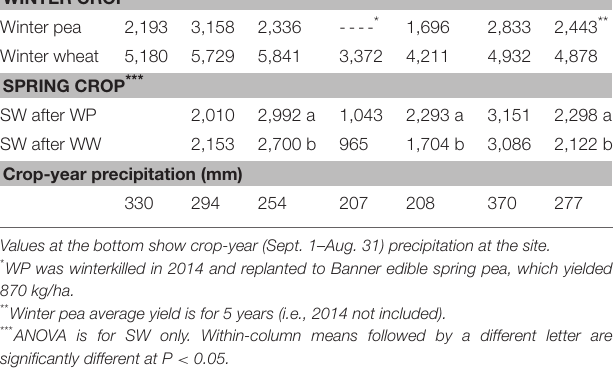
TABLE 4 | Ritzville soft white wheat market prices during the first week of September and winter pea market pool price as well as gross return for these crops based on the yield results of the experiment from 2011 to